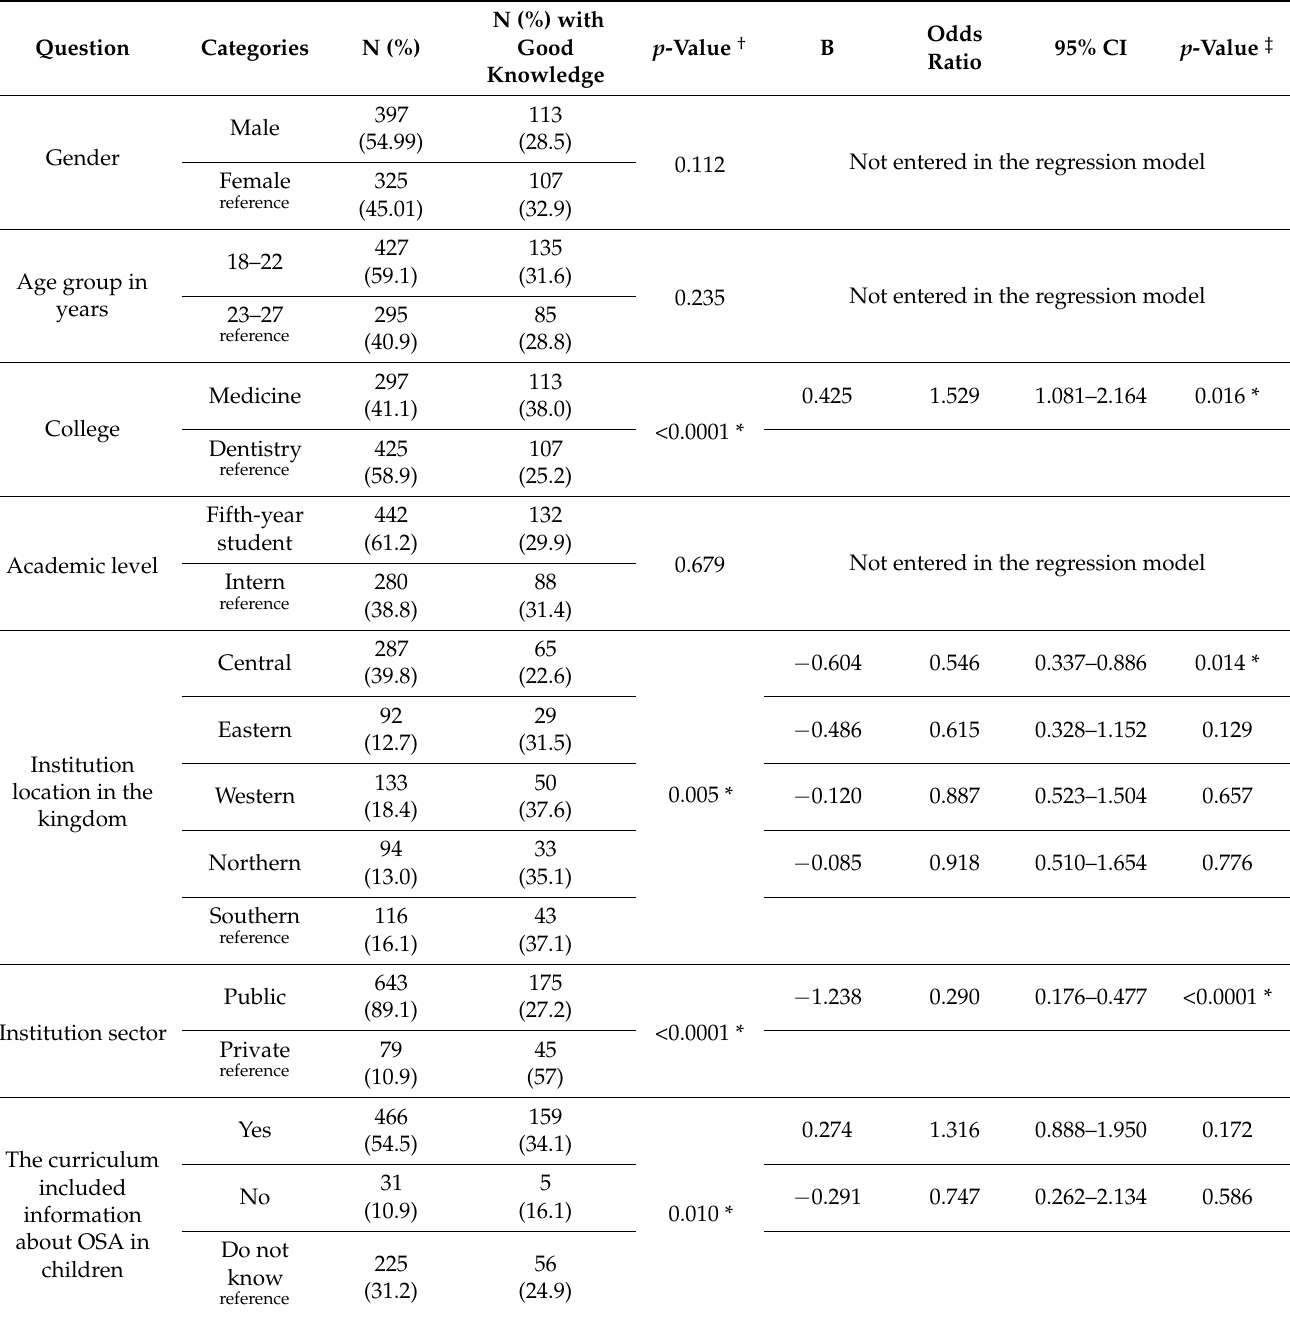
Table 3. The sociodemographic background of the participants and its relation with good knowledge about pediatric